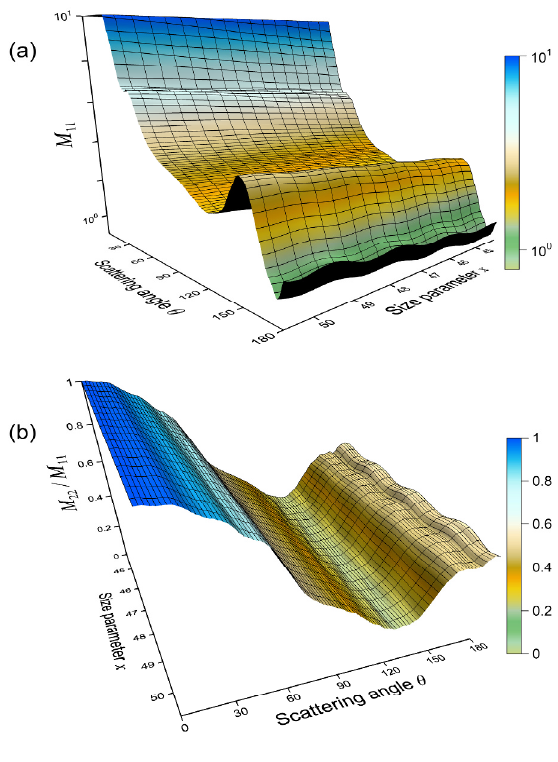
Figure 5. Interference oscillations for the backscattering Mueller